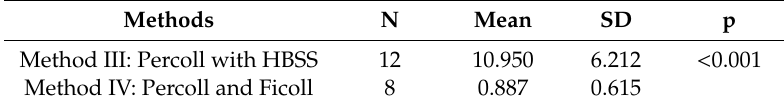
Table 6. Mononuclear contamination analysis of granulocytes isolated by methods III and IV.